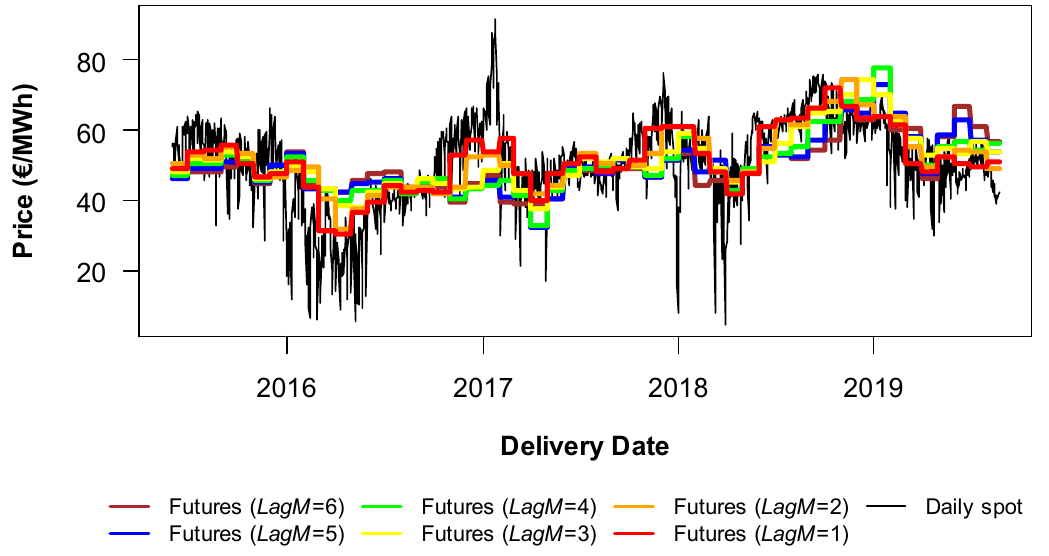
Figure 1. Futures and daily average spot prices for Iberian Electricity Market (MIBEL) in the period studied.